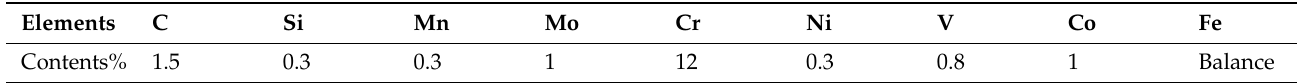
Table 1. Elemental composition of D2 steel [36].